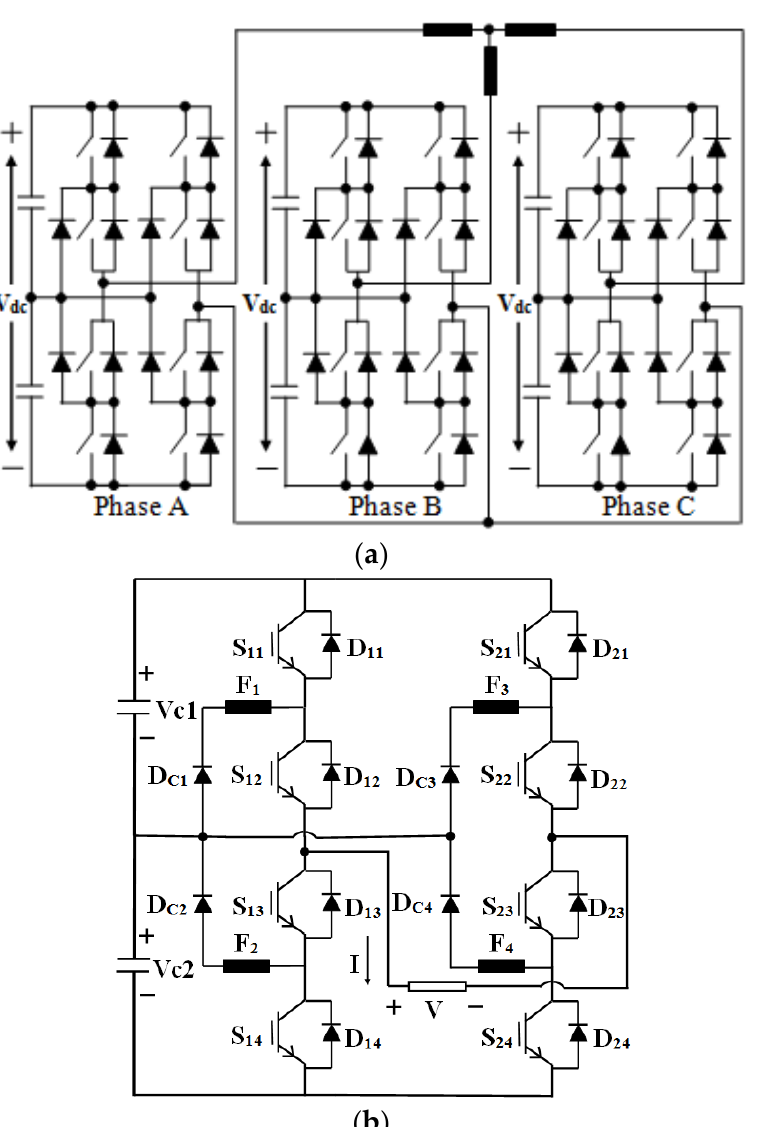
Figure 1. Scheme of ( a ) a conventional three-phase five-level NPC/H-bridge inverter; ( b ) a single- phase five-level NPC inverter with short-circuit fault-tolerant capability (fuses are included). This paper presents a short-circuit fault-tolerant topology which provides the rated voltage and current at the terminals of a three-phase five-level NPC inverter during post- fault operation. The fault-tolerant topology does not contain any redundant component. Compared with the healthy operation, the harmonic content of the terminal voltage and current is not increased during post-fault operation. Since no bidirectional switch is employed neither in single-phase modules or between the phases, fast transition between healthy operation and post-fault operation is